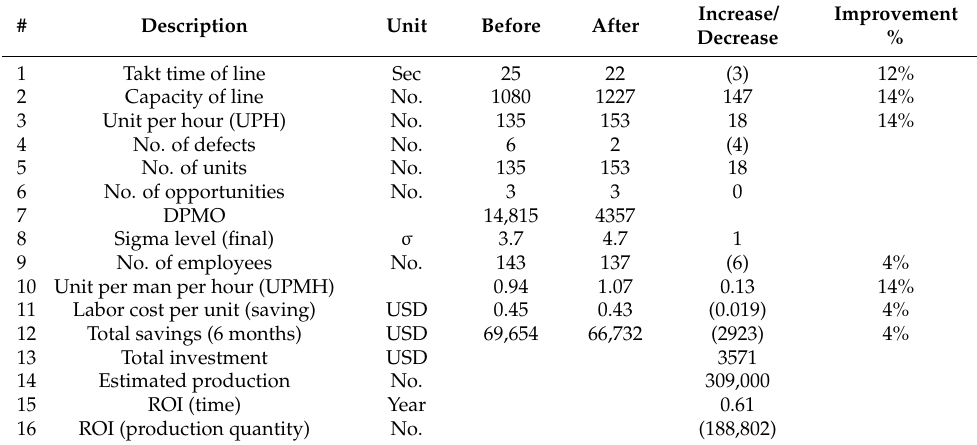
Table 8. Results of power cord design improvement.